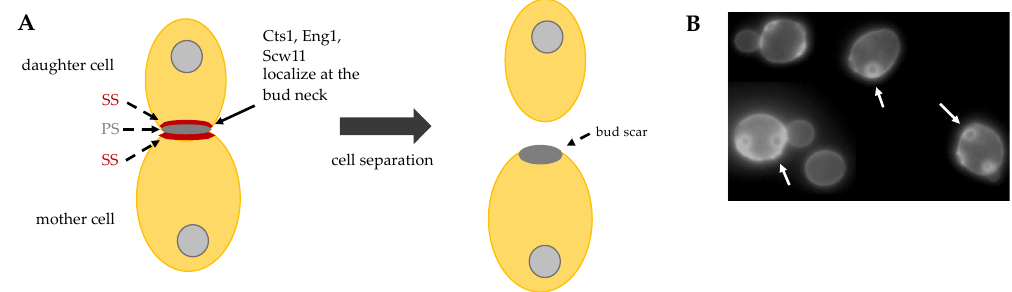
Figure 5. ( A ) Schematic representation of cell separation: after primary septum (PS) and secondary septa (SS) formation, Cts1, Eng1 and Scw11 activity at the daughter bud neck allows for cell separation. ( B ) Budding yeast exponentially growing cells stained with Calcofluor White. On the surface of mother cells these are several scars, chitin-containing rings (arrows), originated during cell division. New born daughter cells do not show bud scars.